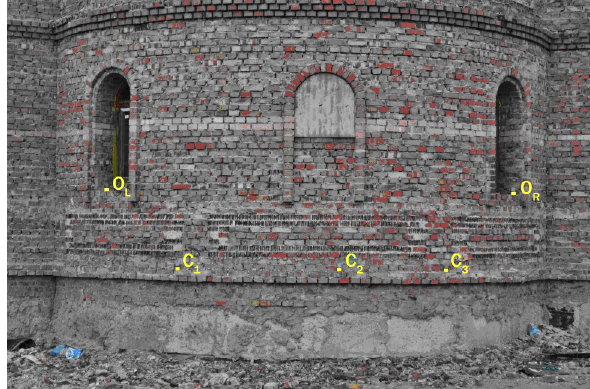
Figure 5. The facade of the church building